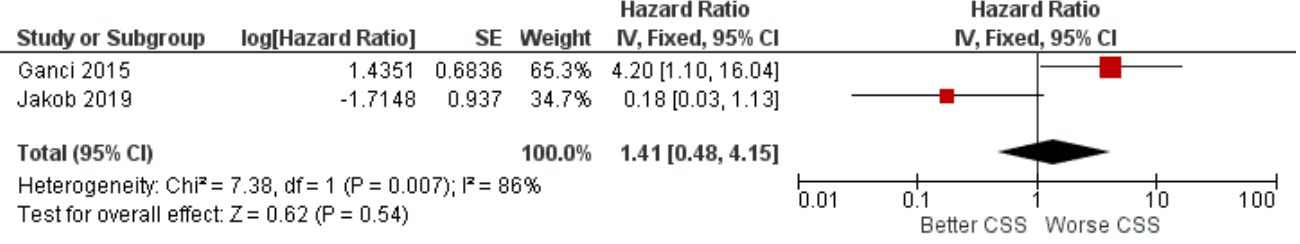
Figure 5. Forest plot of the fixed-effects model of the meta-analysis of the fourth outcome.